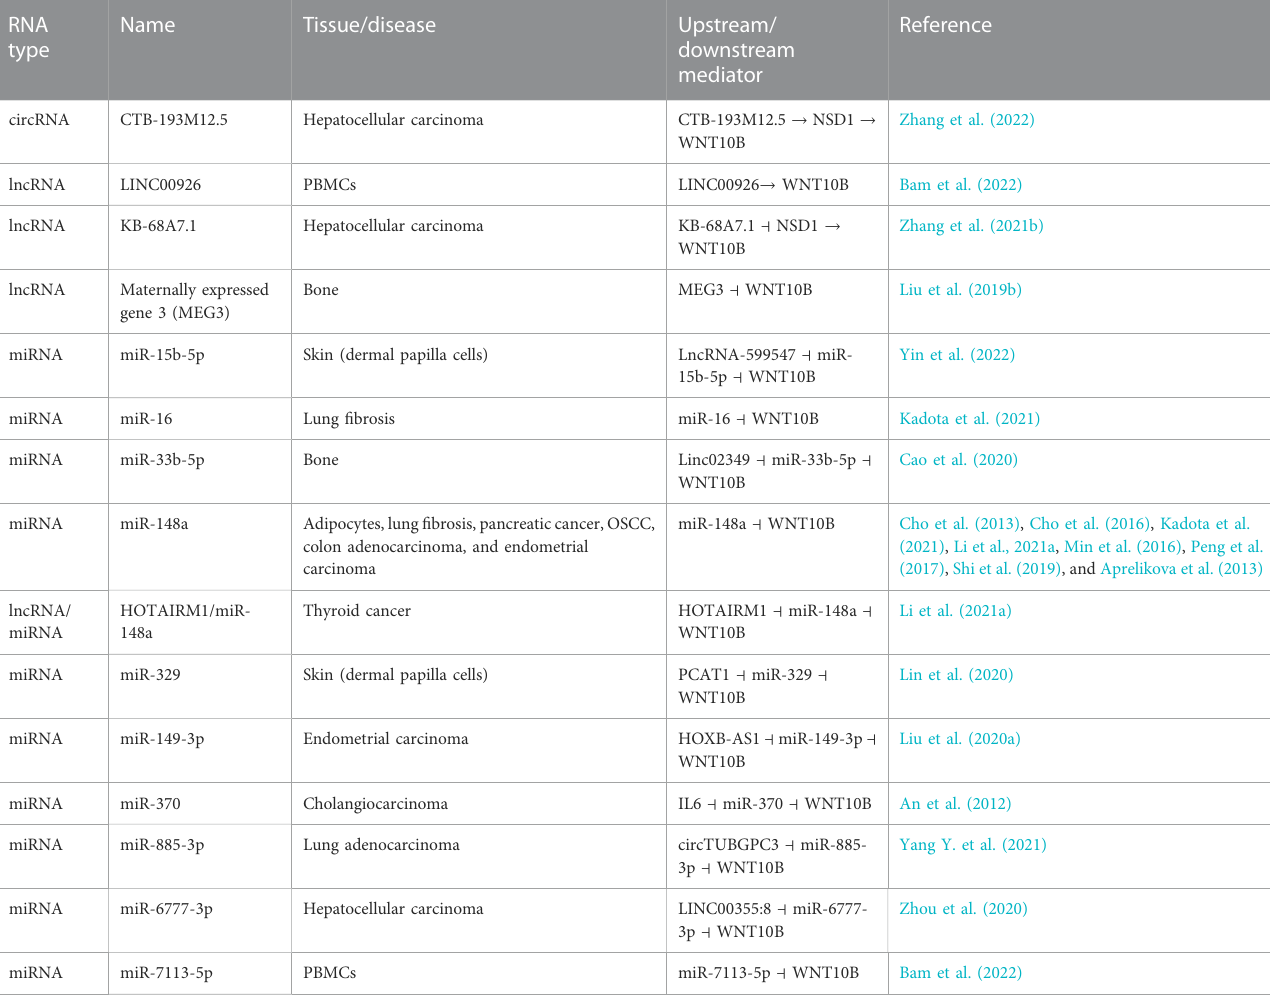
TABLE 1 WNT10B regulation via non-coding RNA/miRNA. RNA